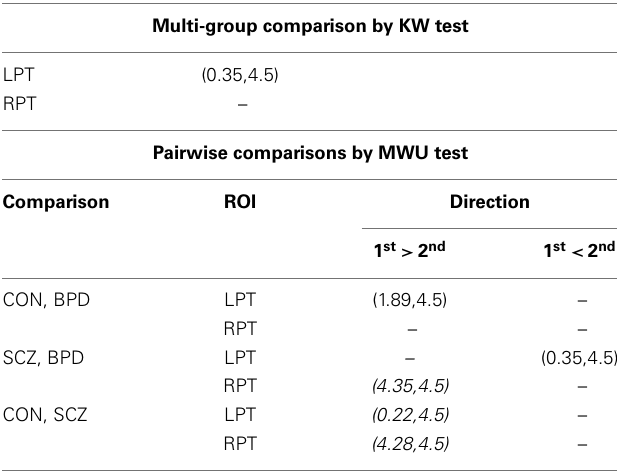
Table 4 | Censored significant p -value cutoffs for LCDM distances compared by diagnosis .